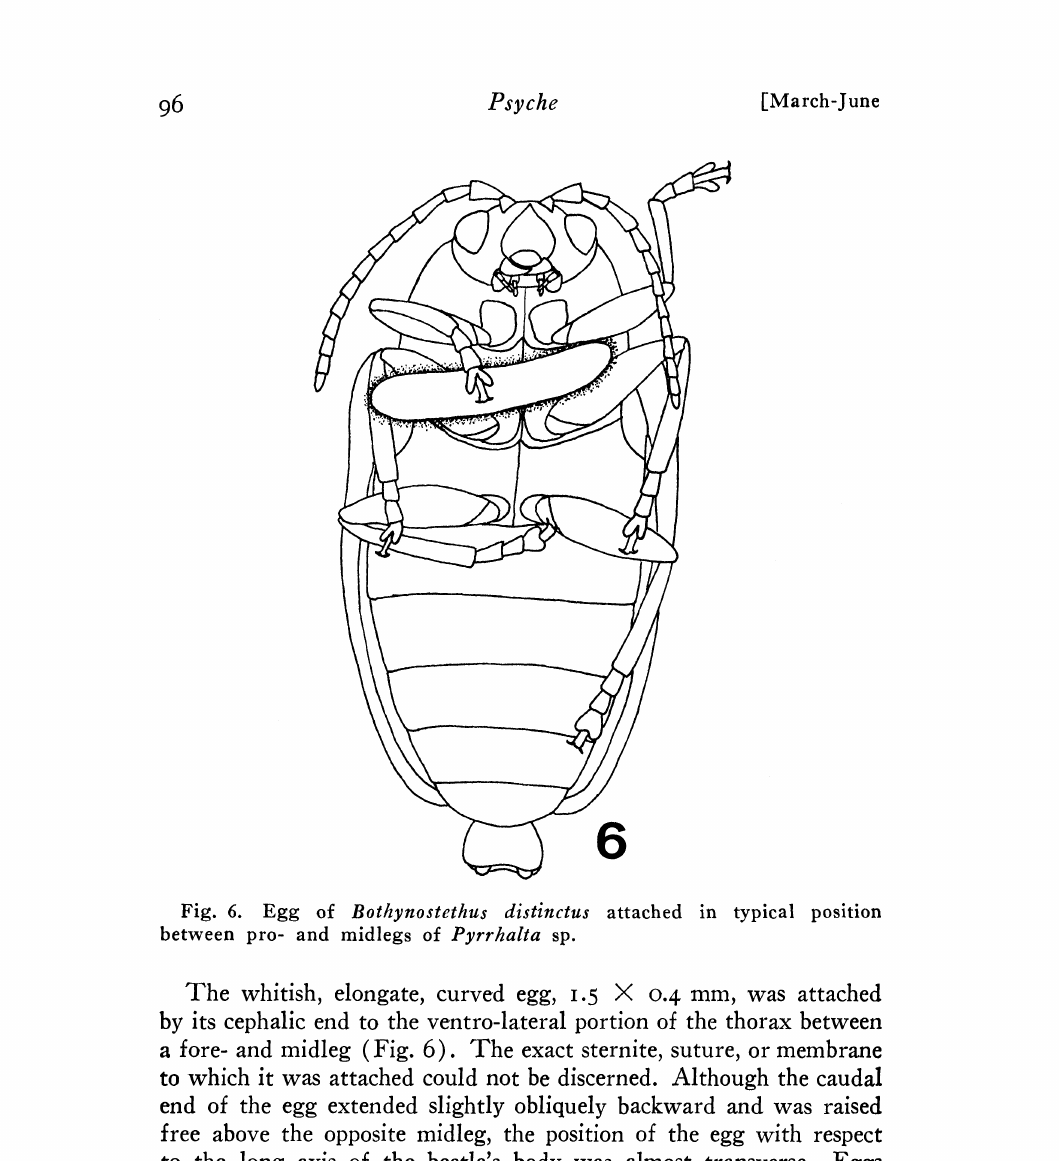
Fig. 6. Egg of Bothynostethus distinctus attached in typical position between pro- and midlegs of Pyrrhalta sp. The whitish, elongate, curved egg, .5 )< 0.4 ram, was attached by its cephalic end to the ventro-lateral portion of the thorax between ore- and midleg (Fig. 6). The exact sternite, suture, or membrane a to which it was attached could not be discerned. Although the caudal end of the egg extended slightly obliquely backward and was raised ree above the opposite midleg, the position of the egg with respect to the long axis of the beetle’s body was almost transverse. Eggs were attached to the left or right sides of the prey in about equal numbers. The larva began eeding at the site o the egg attachment. One larva, 2-mm-long, was noted eeding between the beetle’s fore- and midcoxa, and another, 3-mm-long, was attached near the juncture of the pro- and